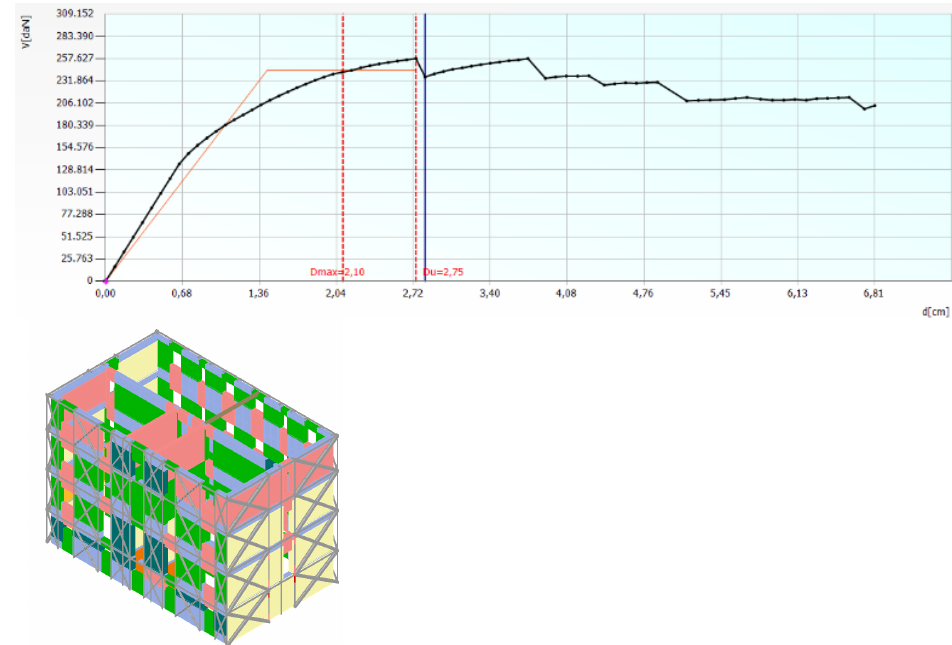
Figure 24. Results of analysis No. 20 in Y-direction on the retrofitted building.